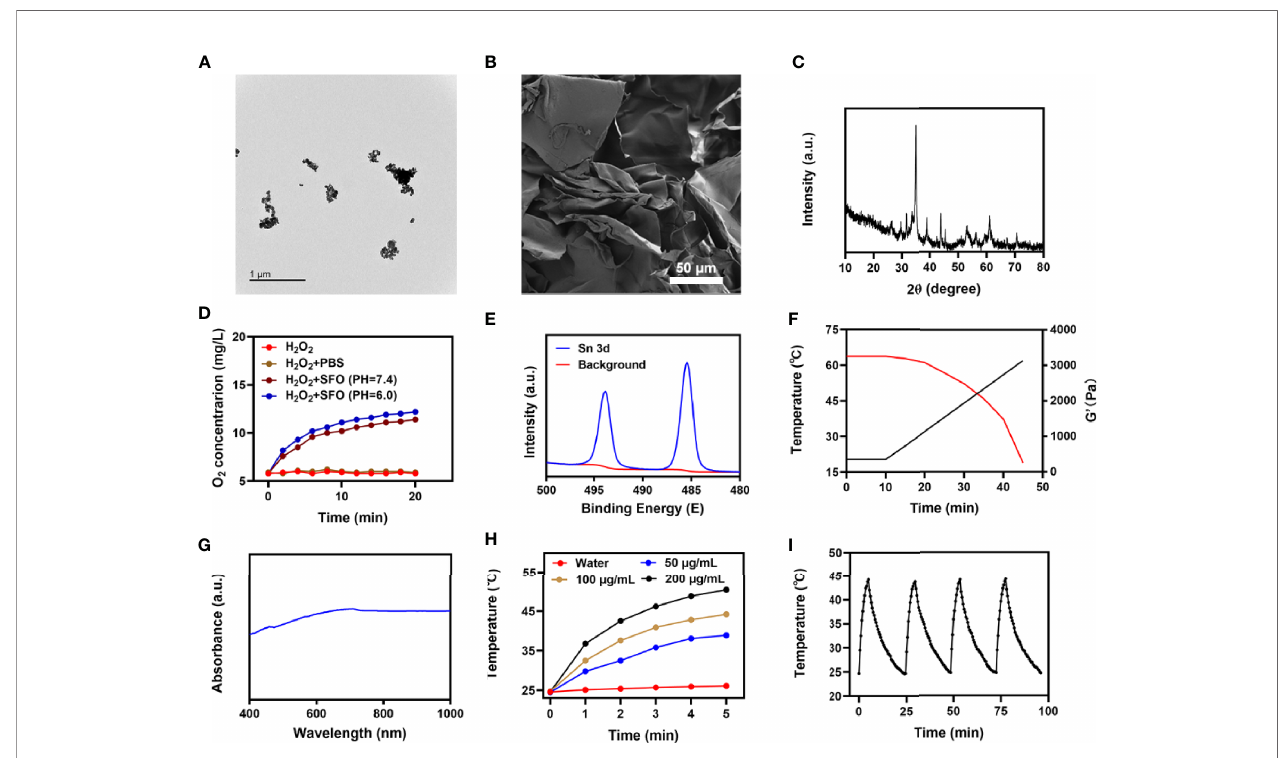
FIGURE 1 | (A) TEM image of SFO. (B) SEM image of hydrogel. (C) XRD pattern of SFO. (D) O 2 generation in H 2 O 2 solution added with PBS or SFO under different pH values (7.4 and 6.0). (E) Sn 3d spectrum of XPS spectra of fresh SFO. (F) Rheological and temperature curves (red and black, respectively) for the prepared SIS in response to 0.5 W/cm 2 808 nm laser irradiation. (G) SFO absorbance spectra. (H) Heating curves for the different concentrations of SFO nanoparticles solutions upon laser irradiation at 808 nm (0.5 W/cm 2 ) for 5 min. (I) Temperature variation of an SFO solution at 200 m g/mL under cyclic laser